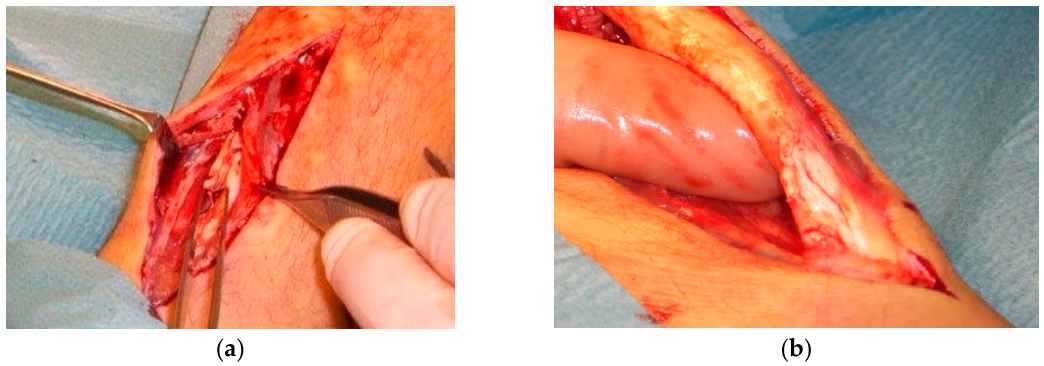
Figure 1. ( a ) Surgical observations in patients with partial Achilles tendon ruptures; ( b ) higher magnification of longitudinal partial Achilles tendon rupture.